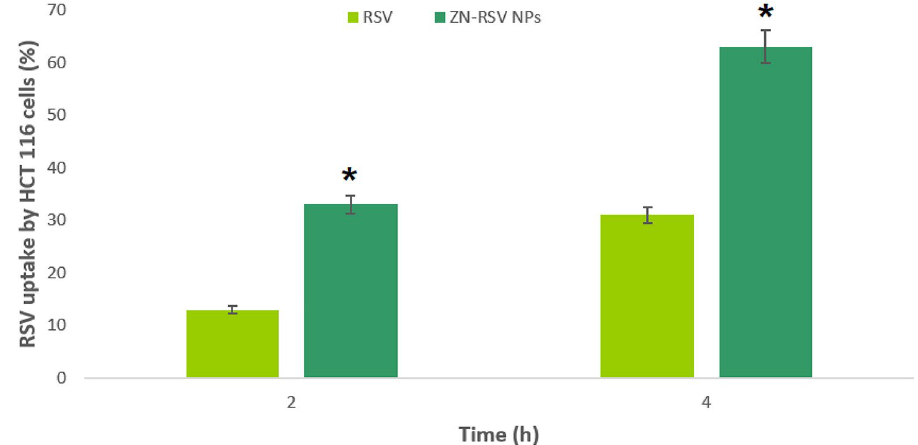
Figure 5. Uptake by RSV by HCT-116 cells at 2 and 4 h. * Significant difference (p <